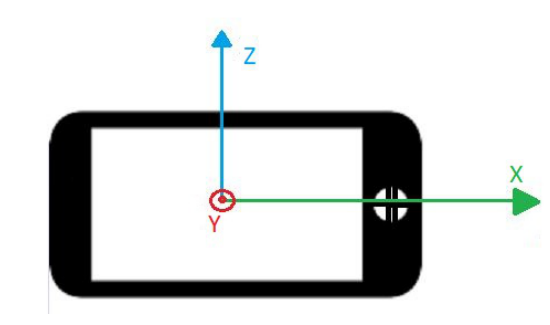
Figure 6. Sensor